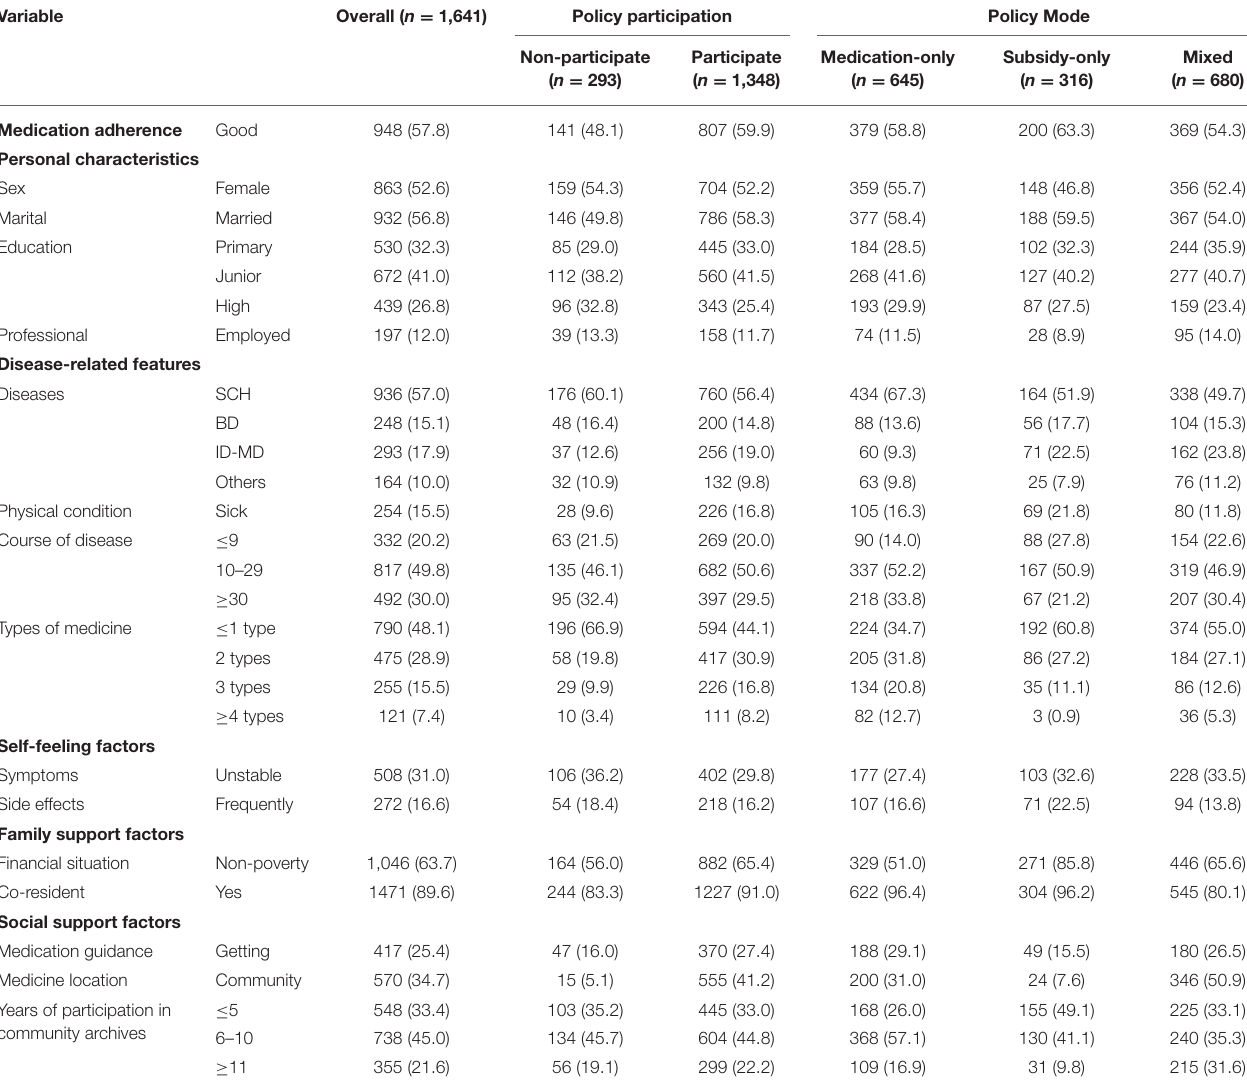
TABLE 1 | Description of respondents